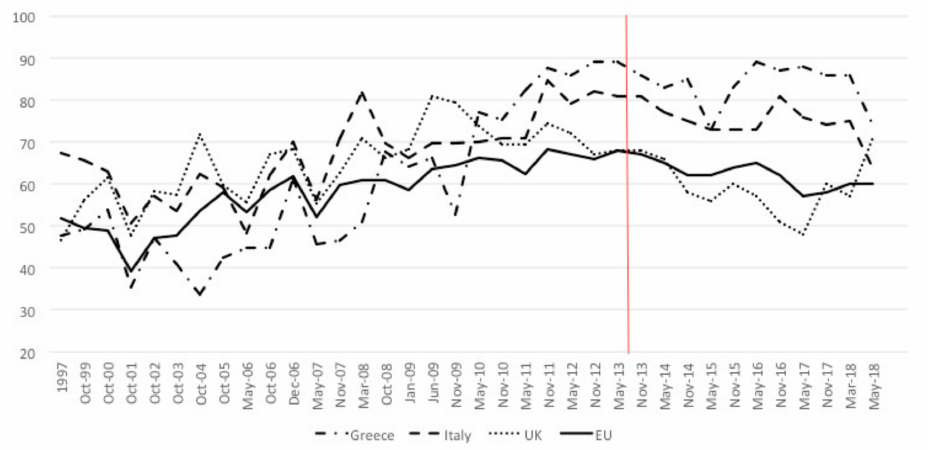
Figure 2. Percentage of citizens that ‘tend not to trust’ their national parliament. Note: Vertical line marks the start of fieldwork (June–September 2013). The EU average includes all member states after European enlargement. Source: Eurobarometers